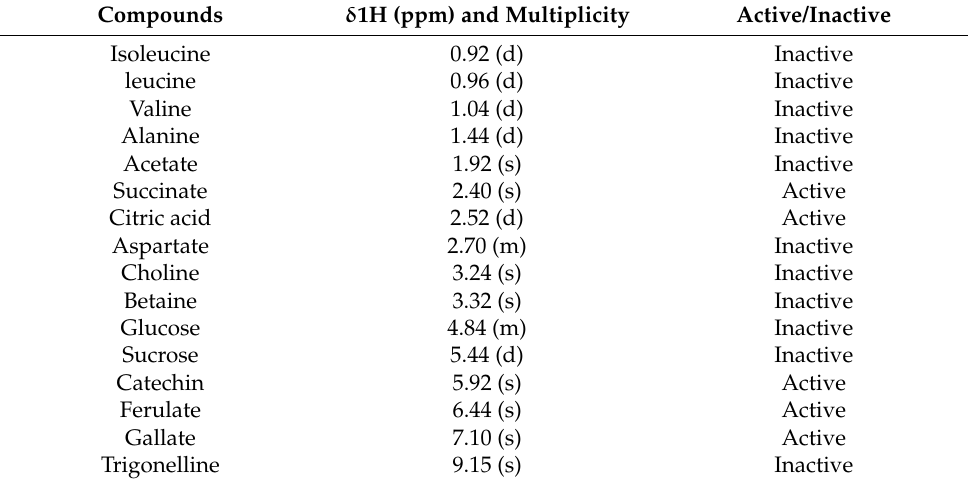
Table 3. 1 H NMR assignment (characteristic 1 H NMR peaks) of some compounds contributing to the differentiation of the active and inactive Vachellia extracts obtained using Chenomx software and the HMDB database. S = singlet; d = doublet; m,